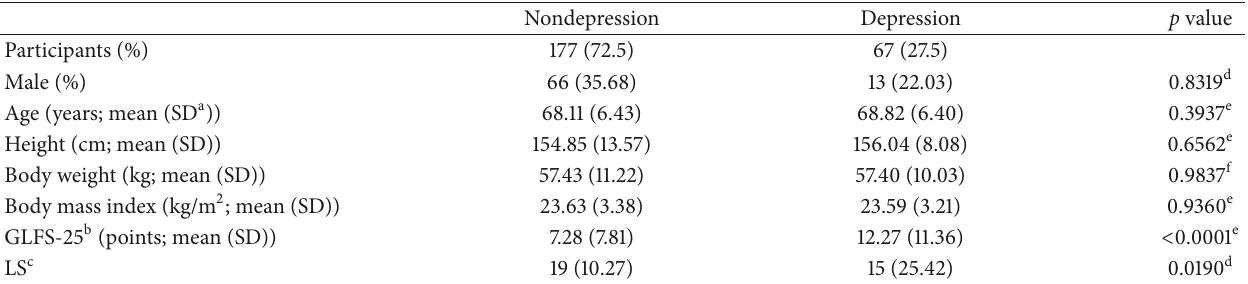
Table 4: Comparison of characteristics between the nondepression and depression